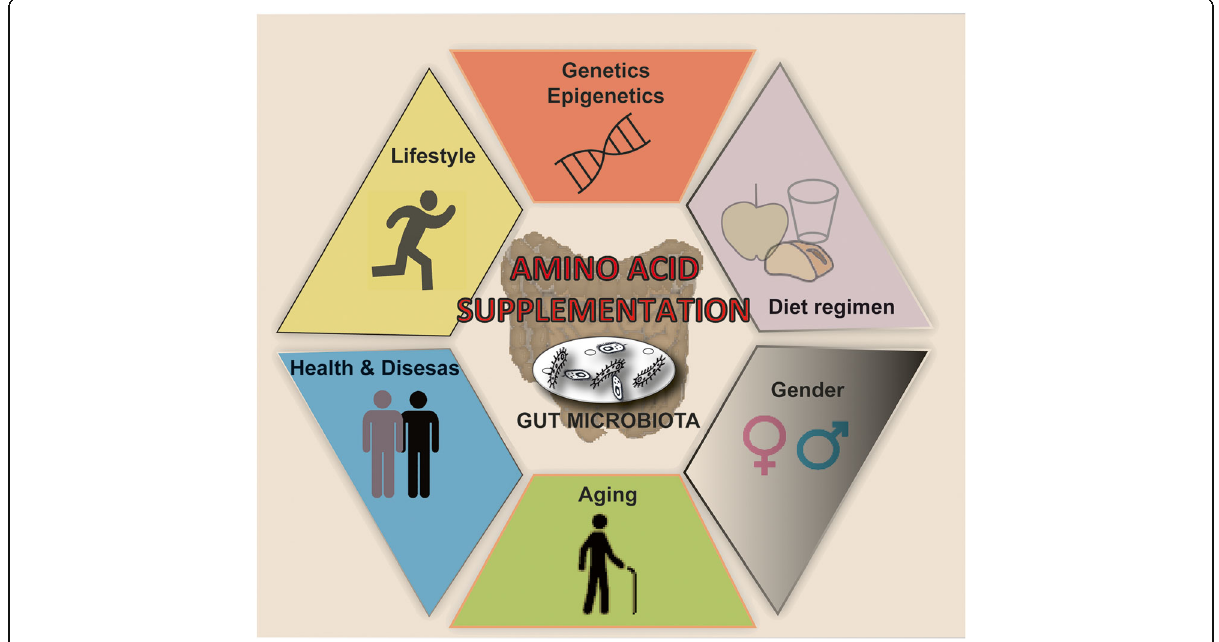
Fig. 1 A large panel of factors can modulate the effects of specific amino acid supplements on gut microbiota. Gut microbiota owns a characteristic plasticity, and a lot of factors can modulate its composition, including genetic, epigenetic, and environmental factors (e.g., diet regimen and lifestyle), as well as aging, gender, and healthy or pathological conditions. Dietary supplementations with peculiar amino